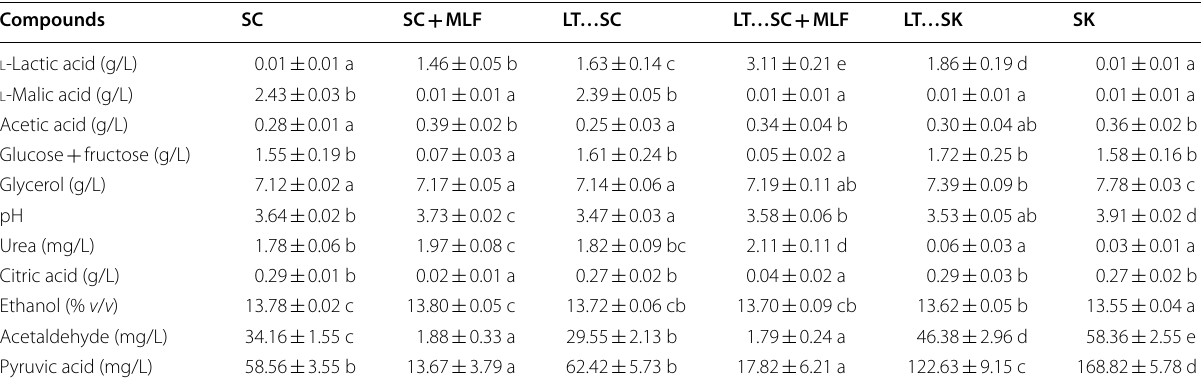
Results are the mean SD of three replicates. Means in the same row with the same letter are not significantly different ( p < 0.05) ±